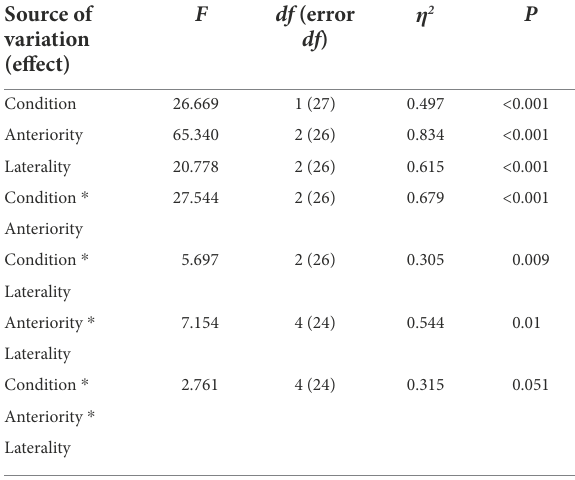
TABLE 4 Results of GLM repeated measures for the auditory oddball